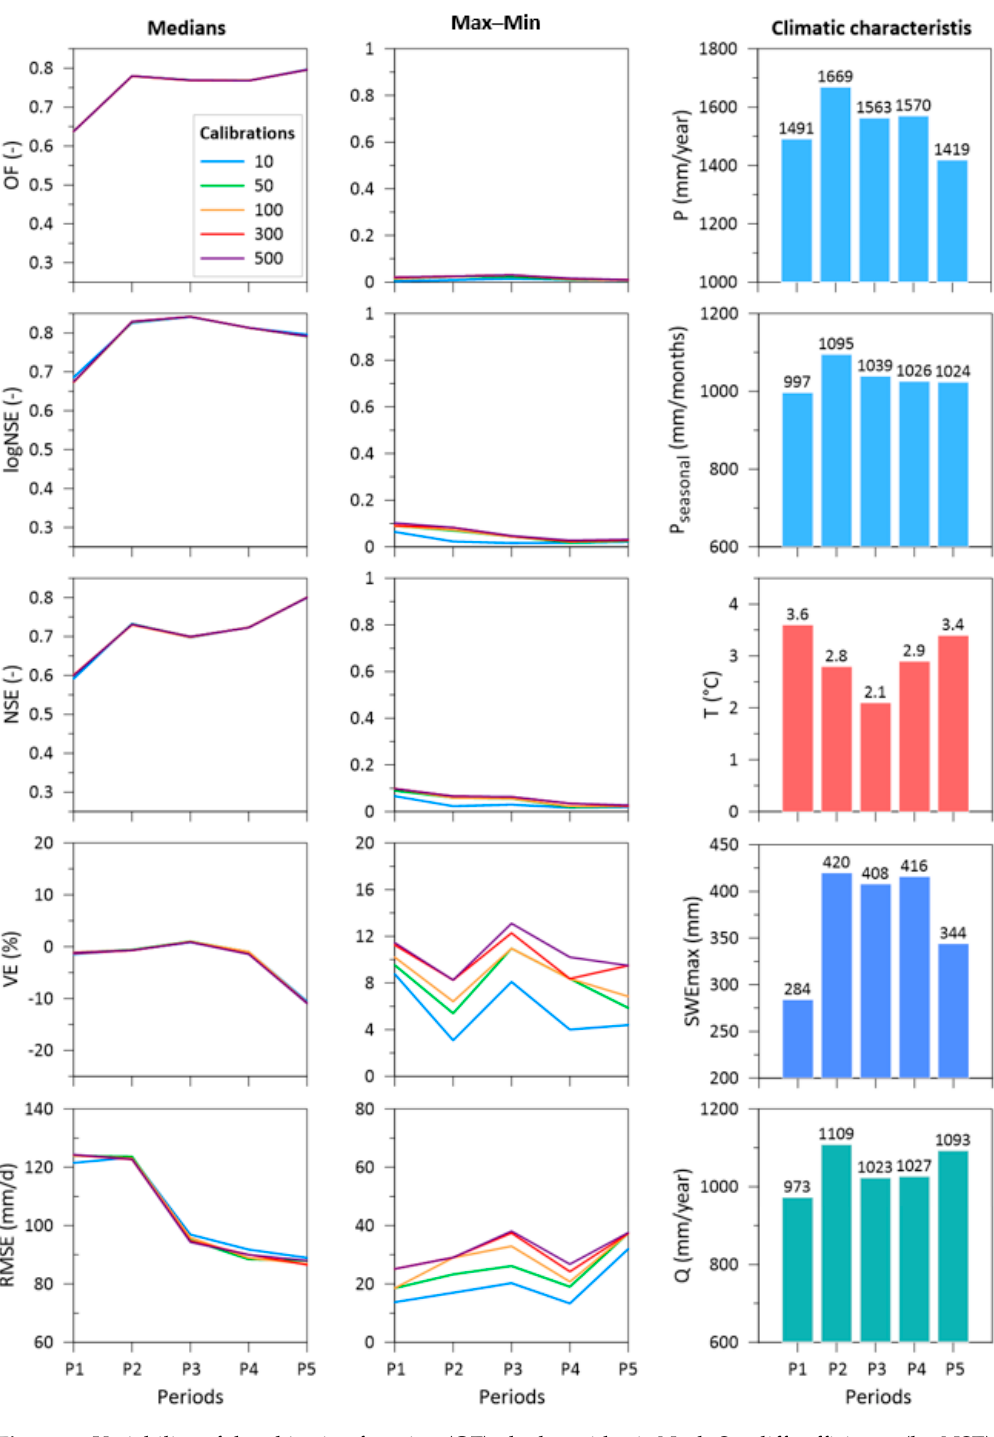
Figure 3. Variability of the objective function (OF), the logarithmic Nash-Sutcliffe efficiency (logNSE), the Nash-Sutcliffe efficiency (NSE), the root mean square error (RMSE) and the volume error (VE) after 10, 50, 100, 300, 500 calibration repetitions in five specific periods. The lines represent the medians and ranges (max–min) of different metrics obtained by different calibration repetitions. The right panel shows the variability of climatic characteristics in the five periods.